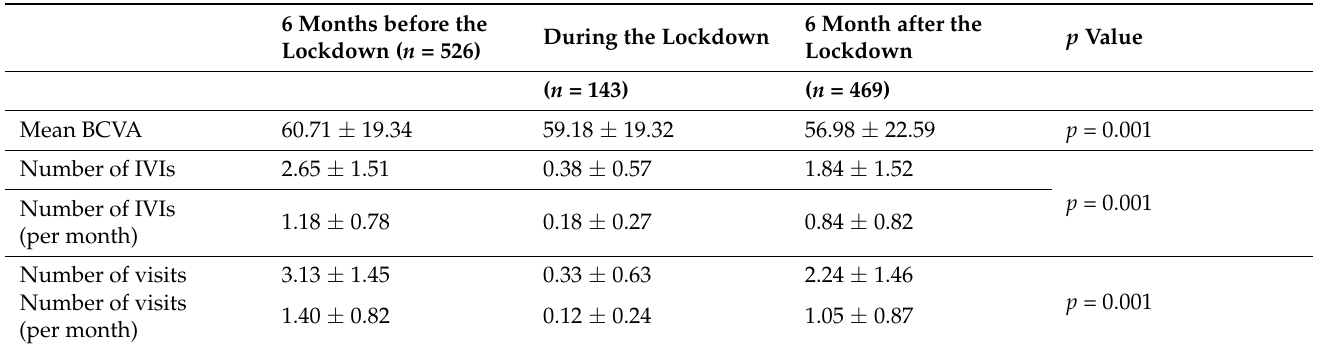
Table 2. BCVA and number of visits and IVIs in each